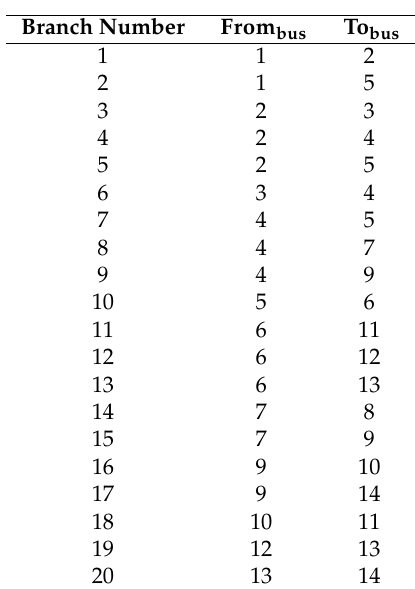
Table A3. IEEE 14-branch data